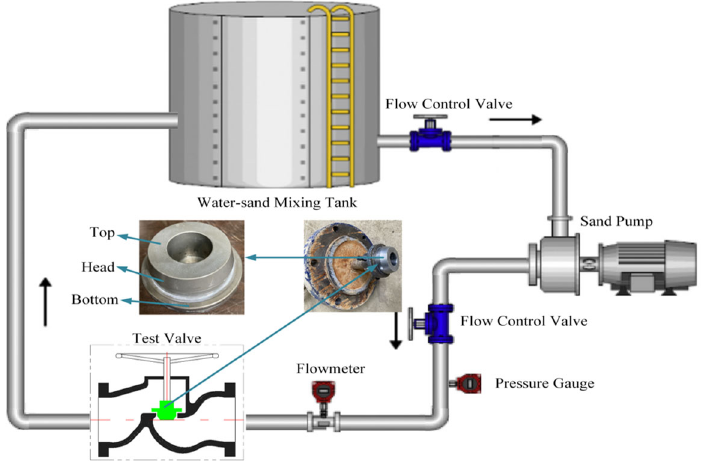
Table 4. Valve erosion test parameters.